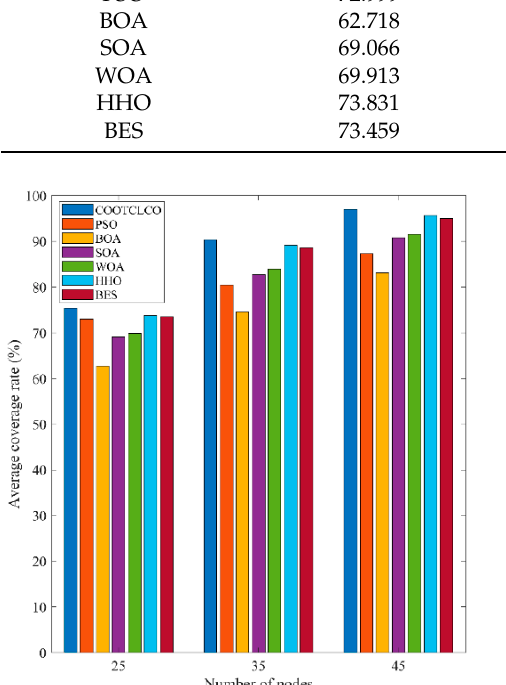
Figure 14. Comparison of average coverage rates under different numbers of nodes.